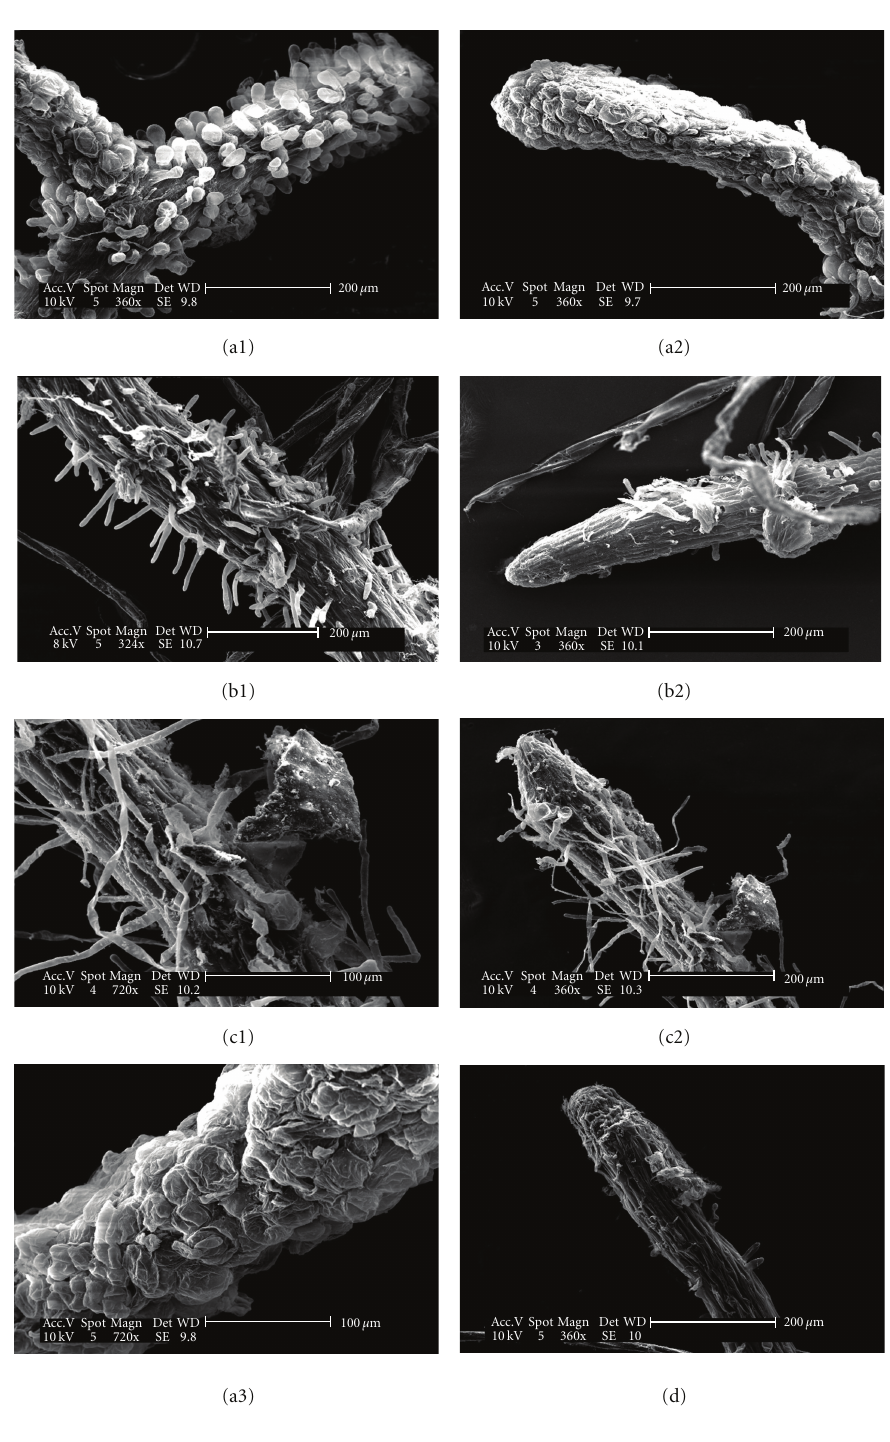
Figure 1: Nemesia roots cultivated on agar (a), paper pulp (b), and control plant (c) from greenhouse. (a1) Root hair of nemesia plant cultivated on agar medium. Note the strongly modified cellular morphology even at higher magnification in (a3). (a2) Root cap of nemesia cultivated in agar medium. No root cap is clearly identifiable. (b1) Root hair structure in nemesia root cultivated on paper pulp. (b2) Root cap of nemesia cultivated on paper pulp. Note the quiet similar structure to the control plant from greenhouse (c2). (c1) Root hair structure of the nemesia root cultivated in peat in greenhouse conditions. (c2) Root cap of nemesia cultivated in greenhouse conditions in peat. (d) Root cap of nemesia cultivated in